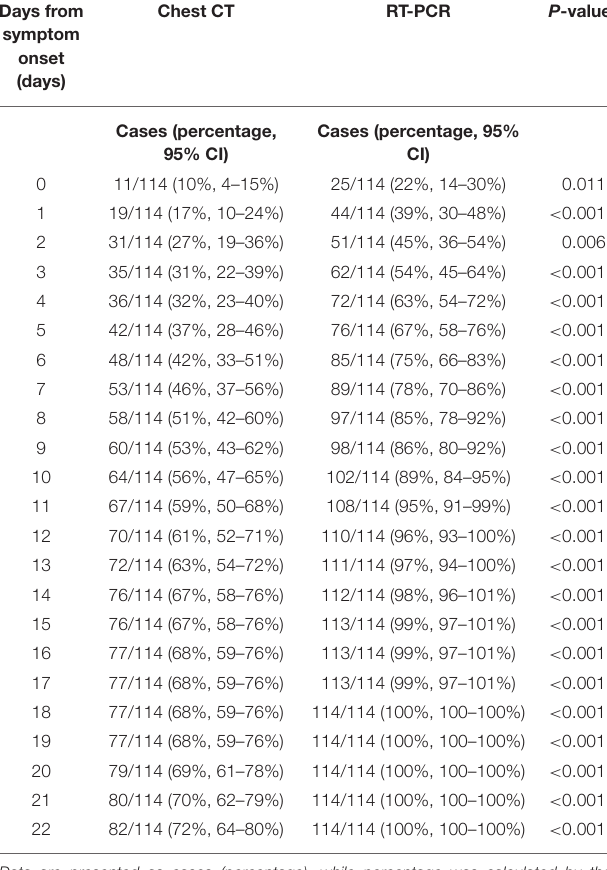
TABLE 5 | Comparison of identified cases by RT-PCR and chest CT over